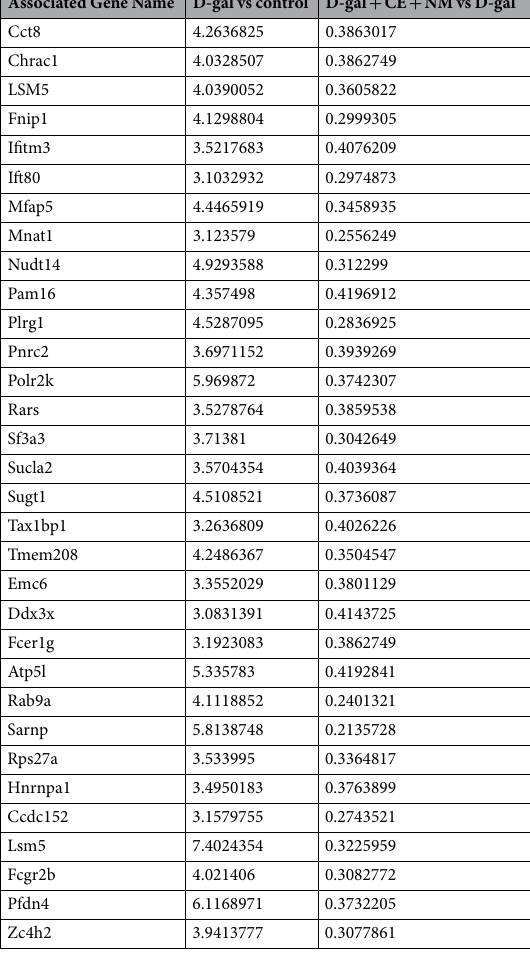
Table 1. The up-regulattion of genes in BMSCs of aging rats. Of 59 genes, threefold change of differential genes expression between control and D-gal